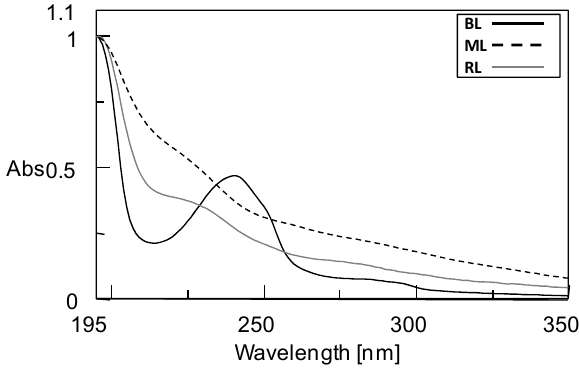
Figure 3. UV spectra of obtained condensates.